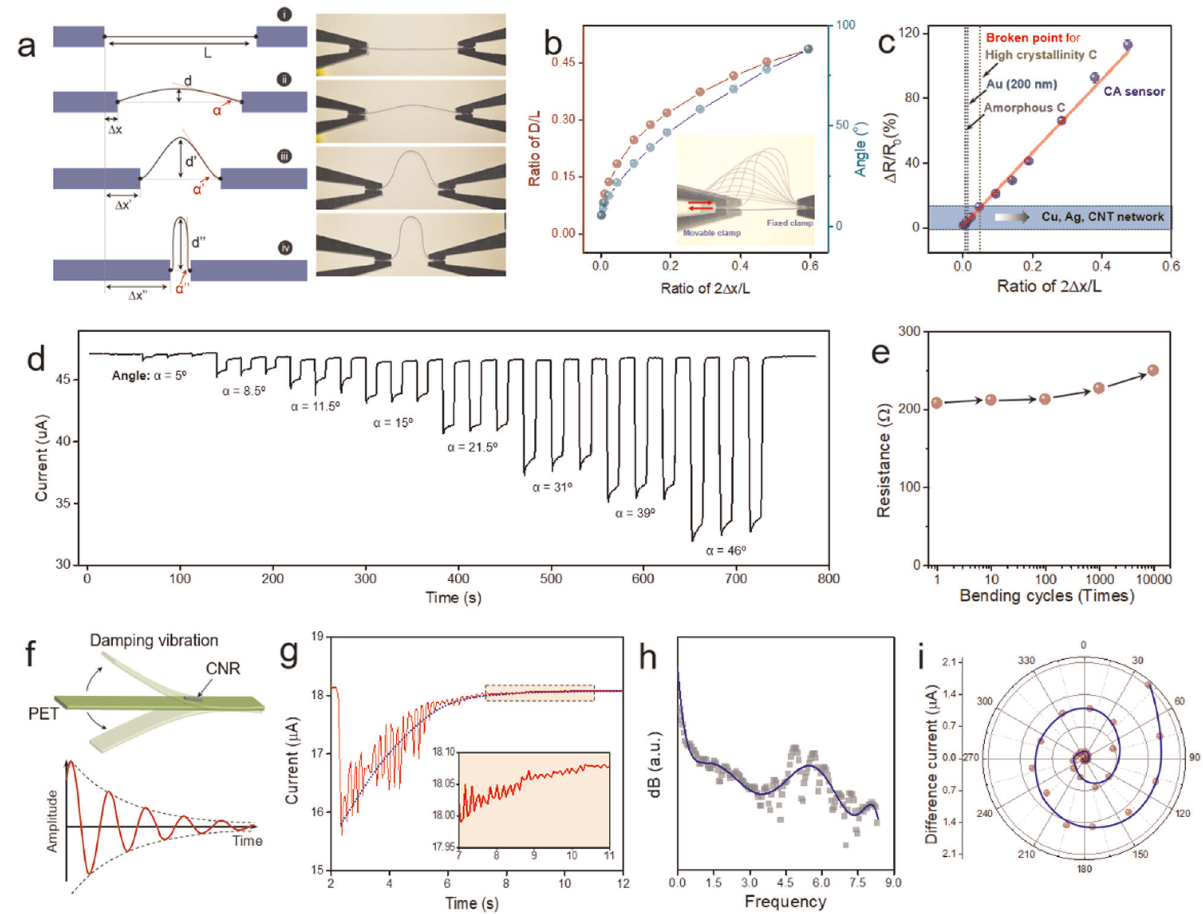
Fig. 4 CAN-based fl exible sensors for the detection of fl exion and low frequency vibrations. a Schematic illustrations and optical graphs of PET substrate with CNA materials under different bending conditions. b The ratio of d/L (the derived height over device size) and bendable angles with the ratio of 2 Δ x/L (the step distance over device size). Inset shows the overlapped optical graphs of device with different bending conditions. c The sensitivity of device with various materials under different bending conditions. d Real-time I – t curve of CNA device with various bending circles. e The resistances of device under different bend conditions. f Schematic illustration of damping vibrations generated by PET substrate, where the CNA-based sensor was set on its surface. g Real-time current response of CNA-based sensors to damping vibrations. h The real-time I – t curve was processed by fast Fourier transform (FFT), which indicates that the dominant frequency of this damping vibration is ~5.5 Hz. i The polar coordinate of the current intensity